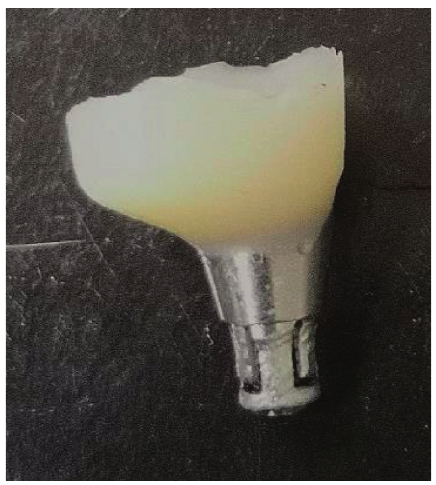
Figure 6: Customized provisional composite